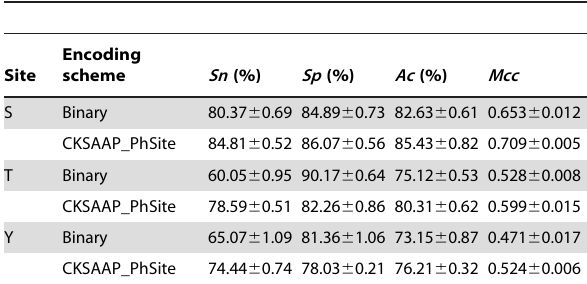
Table 2. Comparison of the two encoding schemes on the training